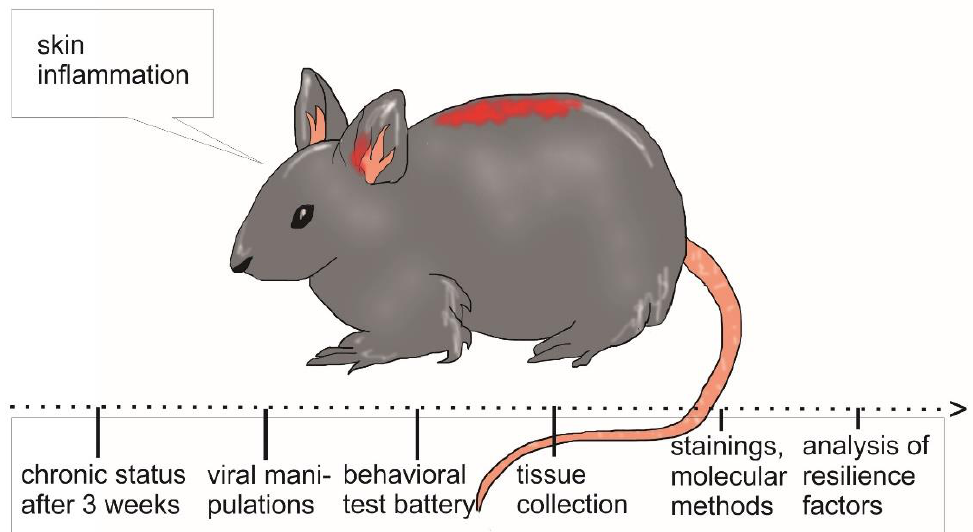
Figure 3. Proposed mouse model for cutaneous inflammation. After inducting a chronic skin inflammation viral intervention, e.g., chemogenetic manipulations can be activated and the animals are subjected to a behavioral test battery, including signature tests for locomotion, anxiety, depression, and learning and memory. Subsequently, tissue samples are collected from the animals and further investigated using immunohistochemistry and molecular methods. The processed samples are then analyzed for changes in inflammatory factors and stress-associated hormones and brain peptides.